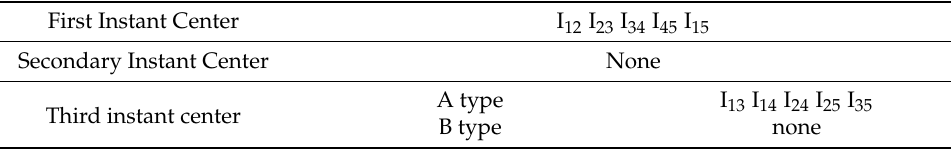
Table 2. Instant centers of five-bar planar